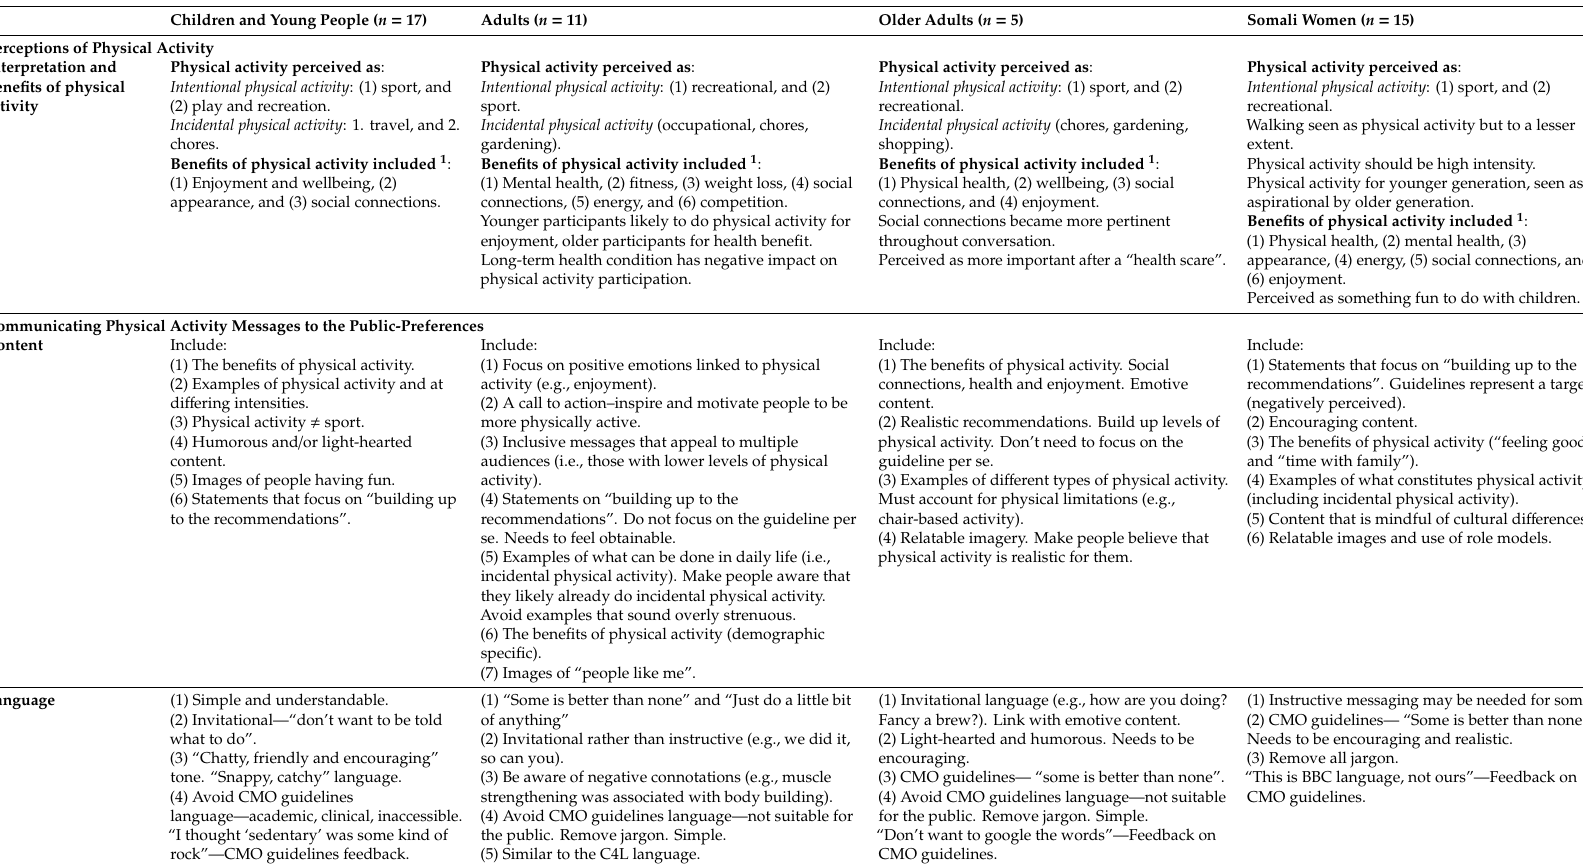
Table 2. Summary of key